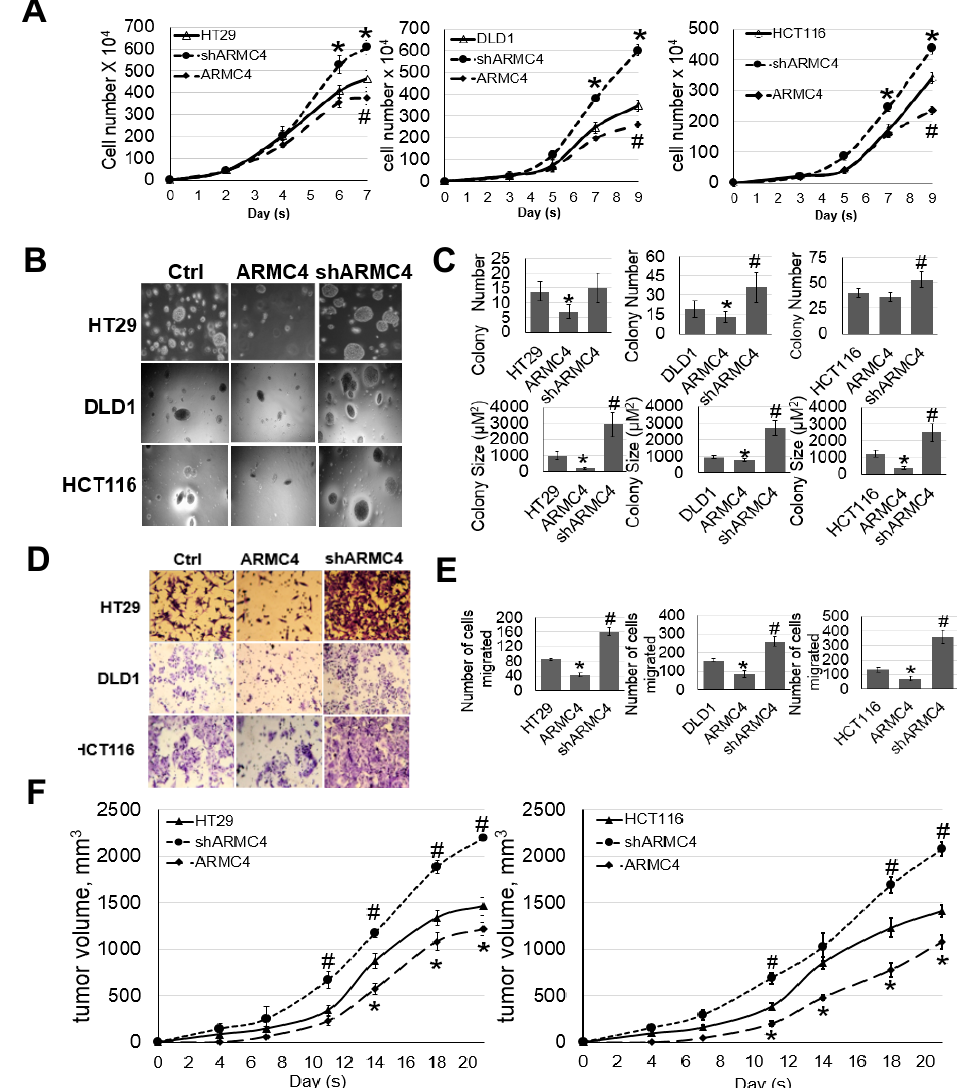
Figure 5. ARMC4 expression decreased cellular proliferation, migratory ability, anchorage-independent growth, and tumor growth. ( A ) Cell growth curve, showing that overexpression of ARMC4 inhibited cell growth compared with the Ctrl group, while shARMC4 knockdown greatly accelerated cell growth. * p < 0.05 ARMC4 vs. Ctrl group; # p < 0.05 shARMC4 vs. Ctrl group. ( B , C ) Anchorage-independent growth (Soft agar assay), showing ARMC4 overexpression cells exhibited dramatically decreased colony size and number compared with Ctrl cells. shARMC4 CRC cells showed increased colony size and number compared with Ctrl cells. * p < 0.05 ARMC4 vs. Ctrl group; # p < 0.05 shARMC4 vs. Ctrl group. ( D , E ) Migration assay using Boyden chamber wells, showing overexpression of ARMC4 decreased migratory ability of CRC cells compared to the Ctrl cells. In contrast, shARMC4 cells had remarkably increased migratory ability. * p < 0.05 ARMC4 vs. Ctrl group; # p < 0.05 shARMC4 vs. Ctrl. ( F ) Tumor growth of cells in an NSG mouse sub-cutaneous xenograft model, showing ARMC4 overexpression, led to decreased tumor growth compared to the Ctrl. shARMC4 led to significantly increased tumor growth compared to the Ctrl. * p < 0.05 ARMC4 vs. Ctrl group; # p < 0.05 shARMC4 vs. Ctrl group. n = 3 independent experiments for all experiments described